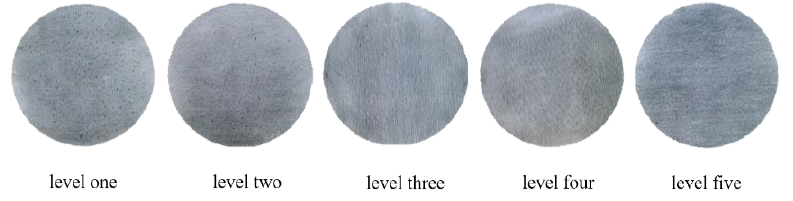
Figure 8. Standard sample of pilling resistance rating for worsted smooth wool fabrics.